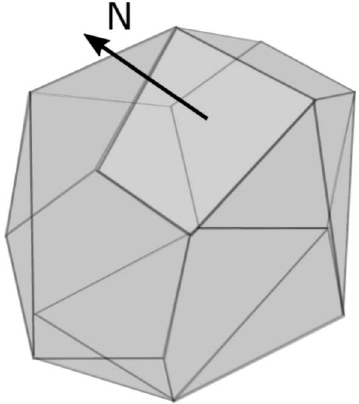
Figure 7. Example of the control volume